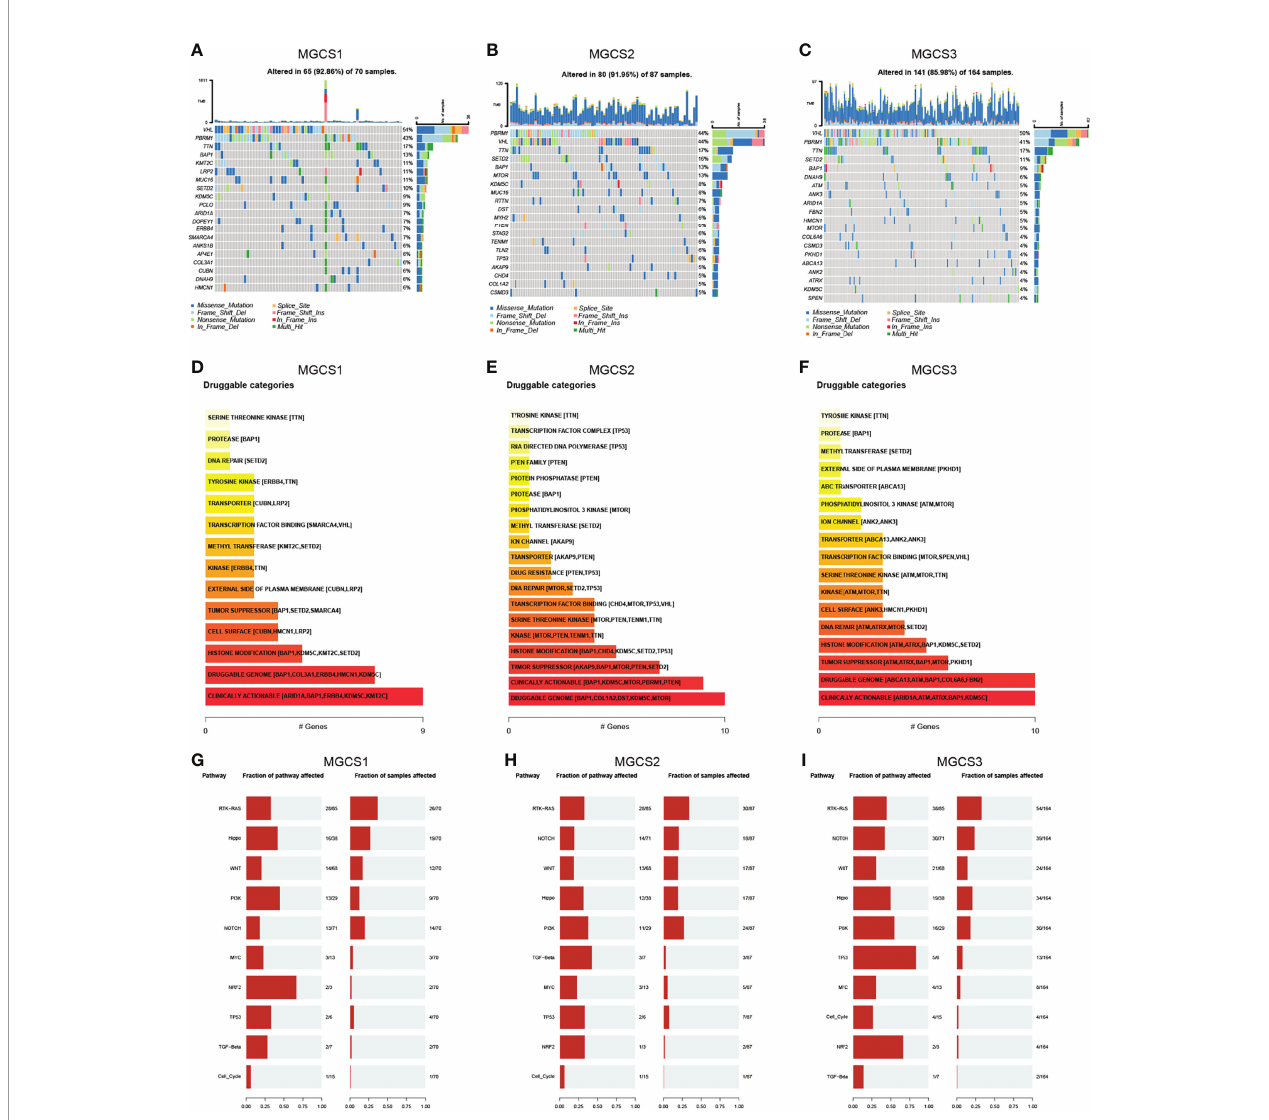
FIGURE 5 | Landscapes of somatic mutation among subgroups. (A – C) Waterfall plot showing the mutation patterns of the top 20 most frequently mutated genes. Each column represented patients. The upper barplot showed tumor mutational burden. The mutation frequency of each gene was indicated on the right. (D – F) Potentially druggable gene categories from mutation datasets in MGCS1, MGCS2, and MGCS3. (G – I) Onco-pathway alteration frequency and the fraction of sample affected for each pathway in MGCS1, MGCS2, and